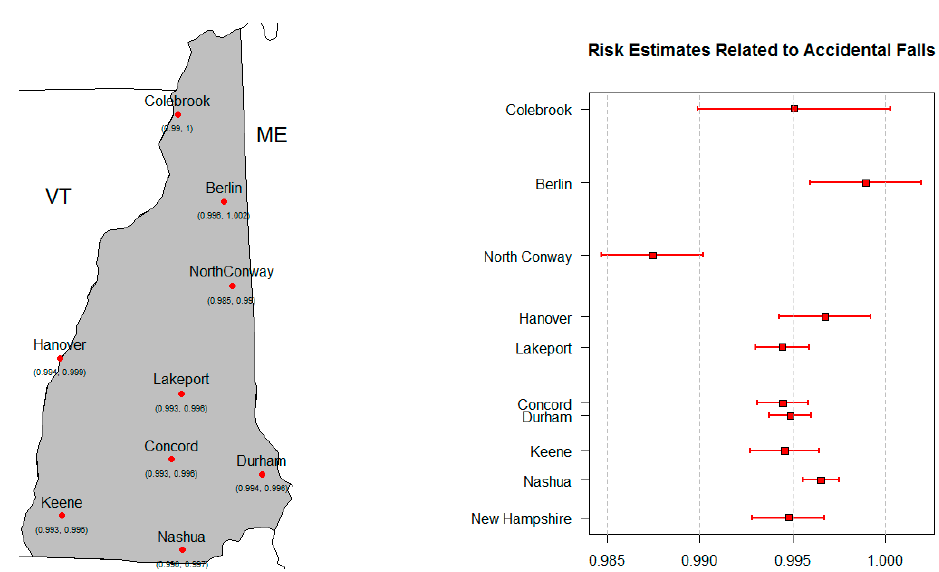
Figure 4. Risk estimates for hospital visits related to accidental falls associated with a 1°C increase in temperature, reported with a 95% CI.